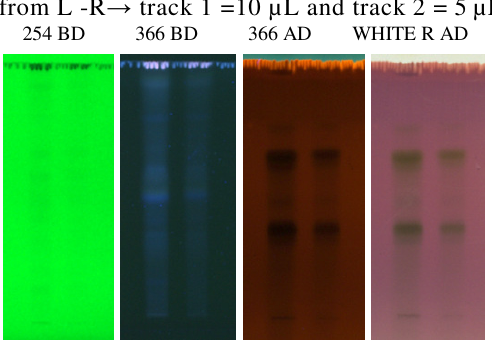
Figure 3. (Plate no 3) HPTLC of saponin